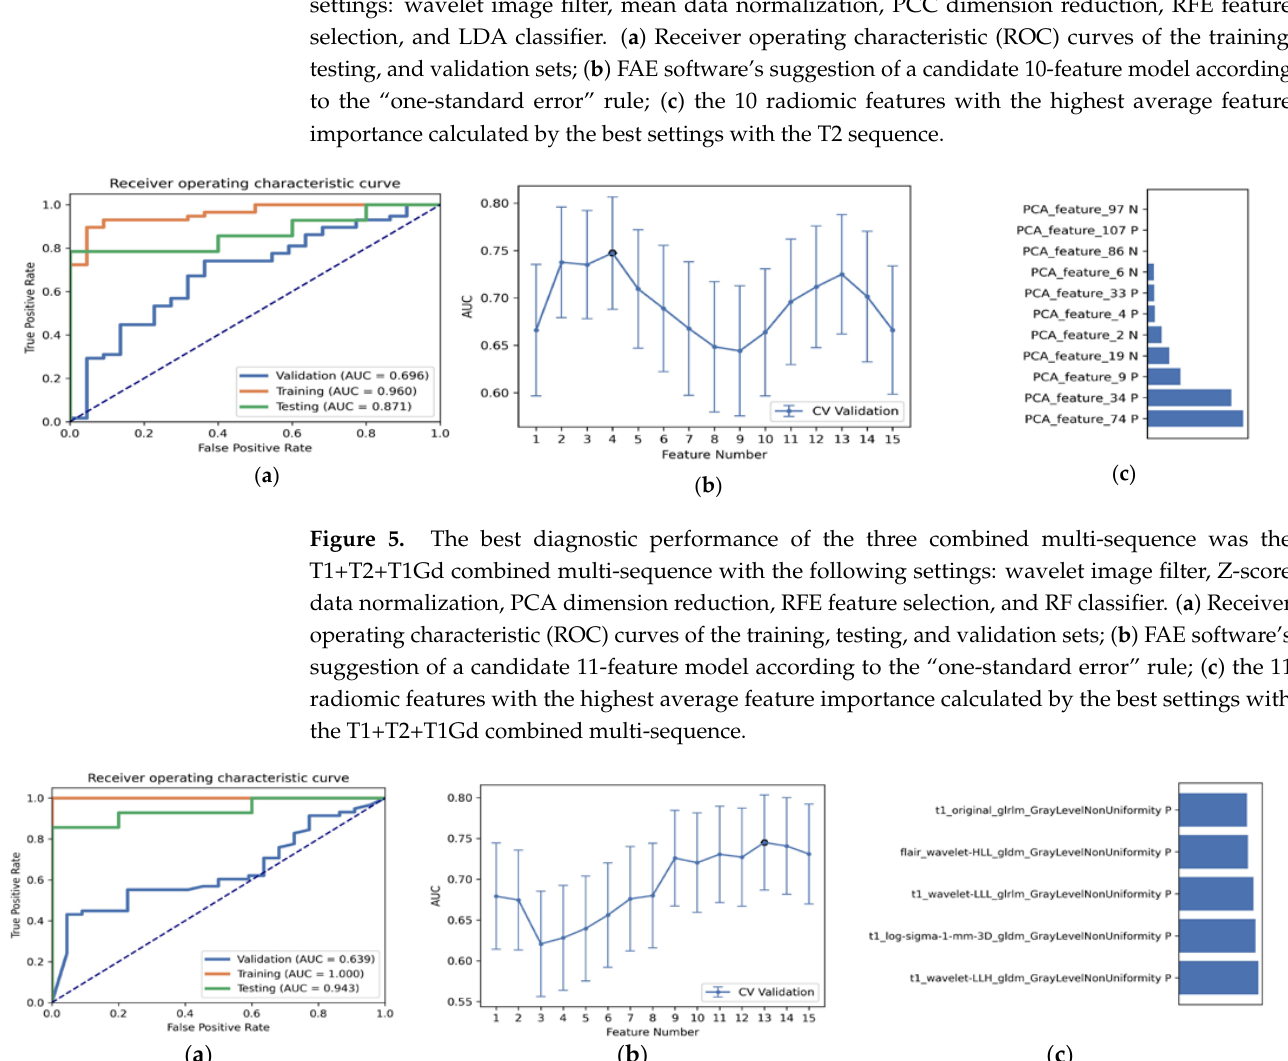
Figure 4. The best diagnostic performance of a single radiomic sequence was T2 with the following settings: wavelet image filter, mean data normalization, PCC dimension reduction, RFE feature selection, and LDA classifier. ( a ) Receiver operating characteristic (ROC) curves of the training, testing, and validation sets; ( b ) FAE software’s suggestion of a candidate 10-feature model according to the “one-standard error” rule; ( c ) the 10 radiomic features with the highest average feature importance calculated by the best settings with the T2 sequence.